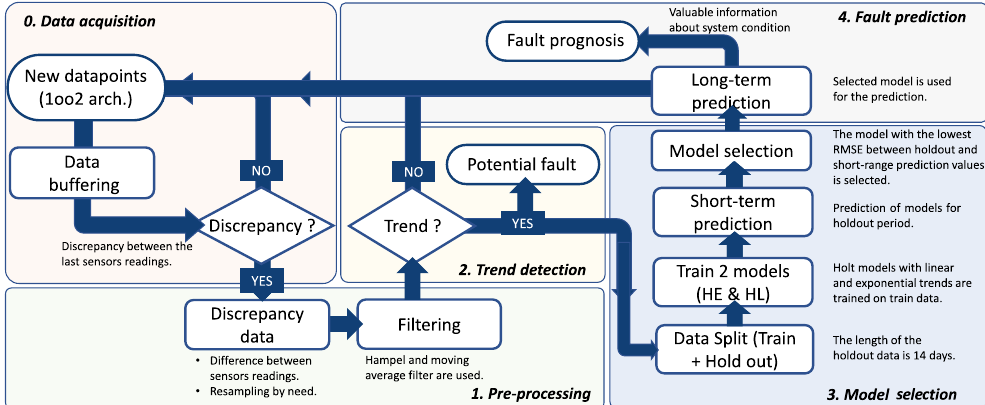
Figure 4. Flowchart outlining the steps in the proposed